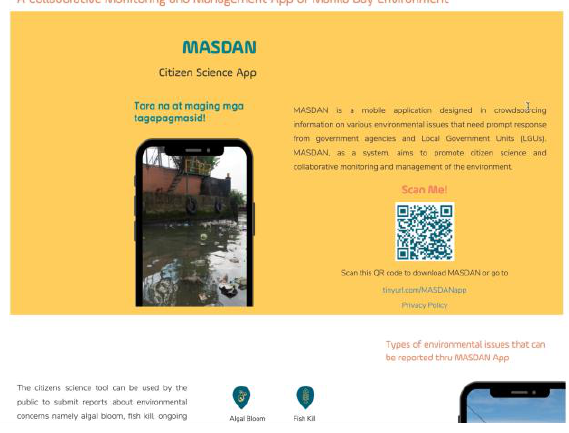
Figure 11. MASDAN citizen science app accessible in the Web